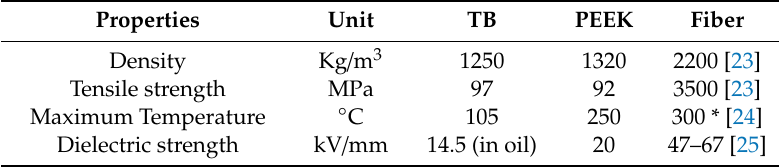
Table 1. Some typical polyether ether ketone (PEEK) [18], transformerboard (TB) [19] and optical fiber physical properties [23–25].